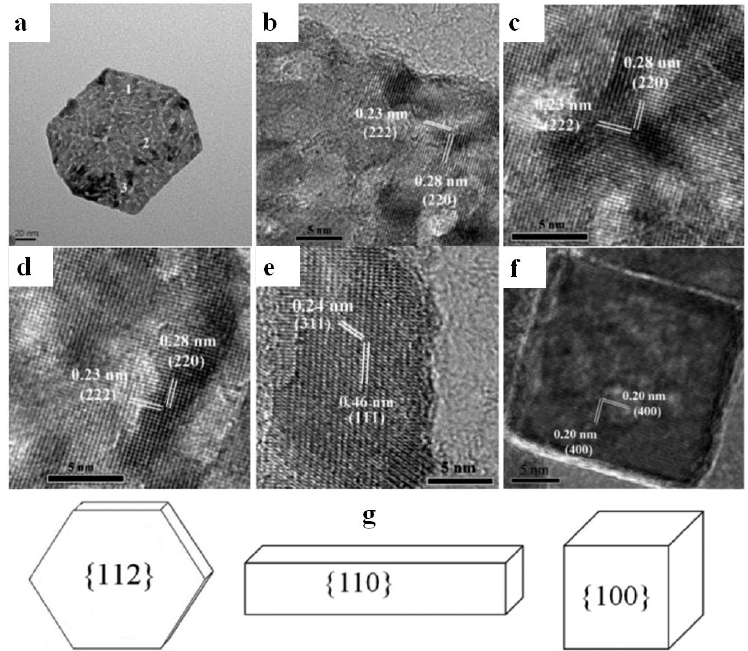
Figure 2. TEM image of a typical Co 3 O 4 nanoplate ( a ), high-resolution transmission electron microscopy (HRTEM) images of site 1 ( a ), site 2 ( c ) and site 3 ( d ) of Co 3 O 4 nanoplate, a HRTEM image of a Co 3 O 4 nanorod ( e ), a HRTEM image of a Co 3 O 4 nanocube ( f ) and exposed crystal planes on the nanorod and nanocube of Co 3 O 4 ( g ). Reproduced from Reference [103] with permission from the PCCP Owner